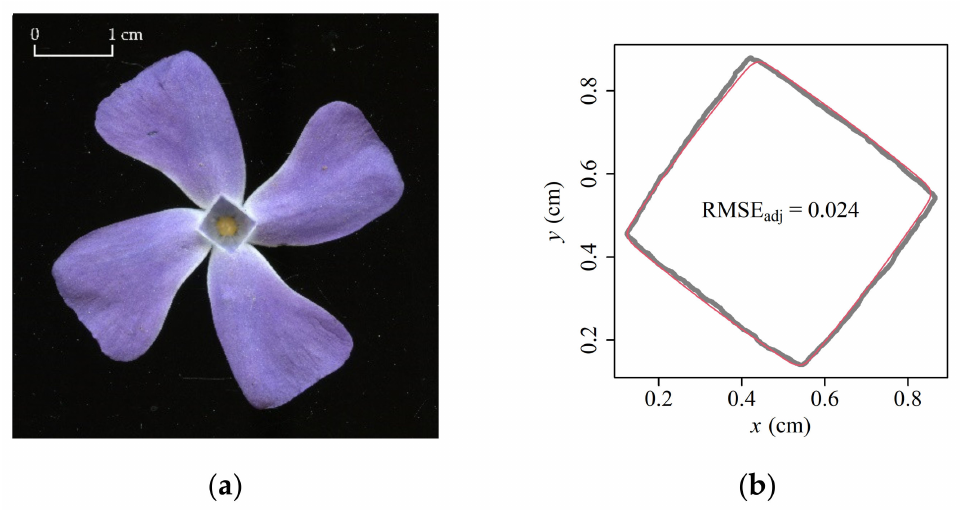
Figure 6. The vertical projection of V. major flower with four petals ( a ), and the comparison between the observed and predicted ORCTs ( b ). In panel ( b ), the gray curve represents the observed ORCT and the red curve represents the predicted ORCT using Model 2. Presentation and symbols as in Figure